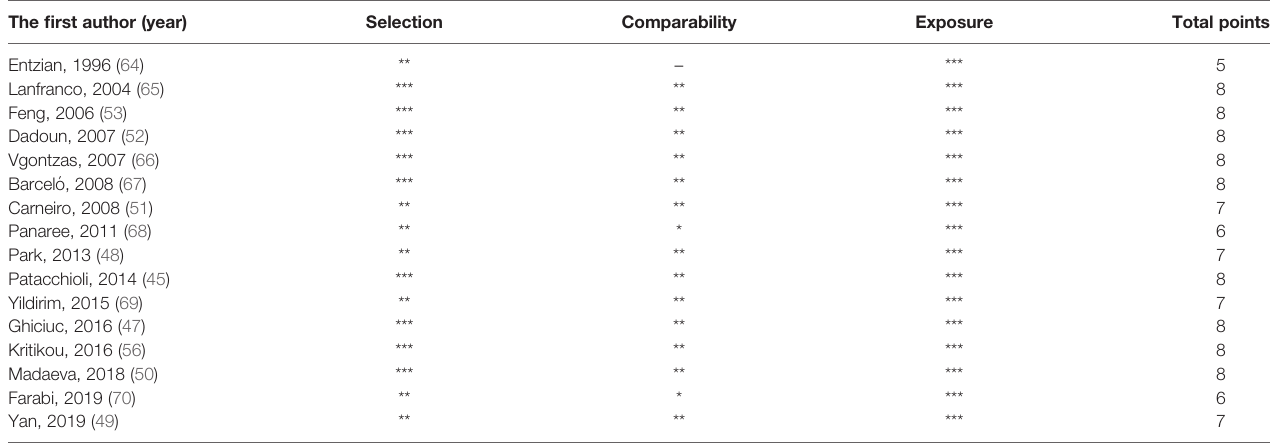
TABLE 3 | Quality assessment scores of the studies involved in the meta-analysis.